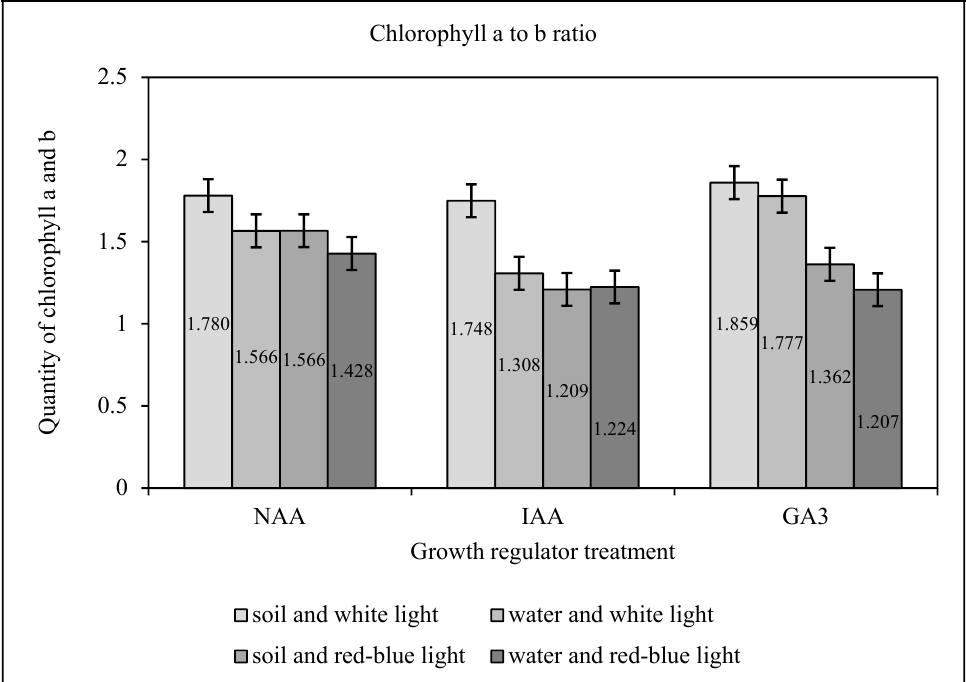
Figure 4. Chlorophyll a to b ratios in seedlings germinated from pelleted seeds under various controlled conditions. Vertical bars indicate the standard deviation. IAA—indole-3-acetic acid, GA 3 —gibberellic acid, NAA—1-naphthaleneacetic acid. Table 4. Percentage amounts of chlorophyll in Scots pine seedlings germinated in various treatment conditions. * 100 percent of the largest ratio Chlorophyll a to chlorophyll b (Chla/Chlb) = 1.859 was the basis for calculating the percentages.